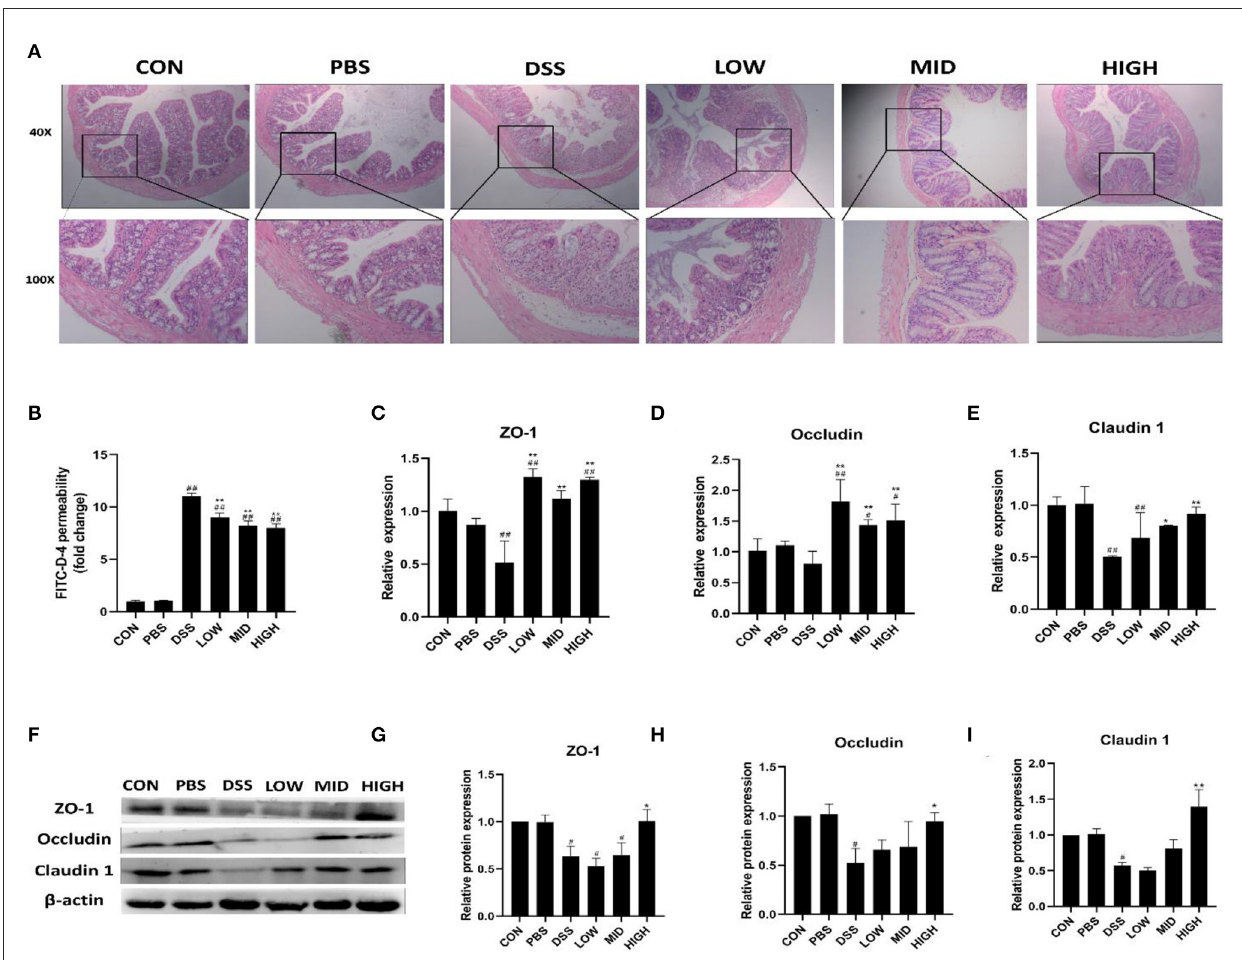
FIGURE10 The effect of BTL-1 on the intestinal injury of IBD mouse model induced by DSS. Histopathological changes after DSS stimulation in the colon (A) . The in vitro intestinal barrier function evaluated by FITC-D fluorescence intensity (B) . Upregulation of BTL-1 on tight junction proteins as determined by qPCR (C–E) and western blotting (F–I) . The results were expressed as the means ± SEM of n = 3. # P < 0.05, ## P < 0.01, compared to control group, * P < 0.05, ** P < 0.01 compared to DSS